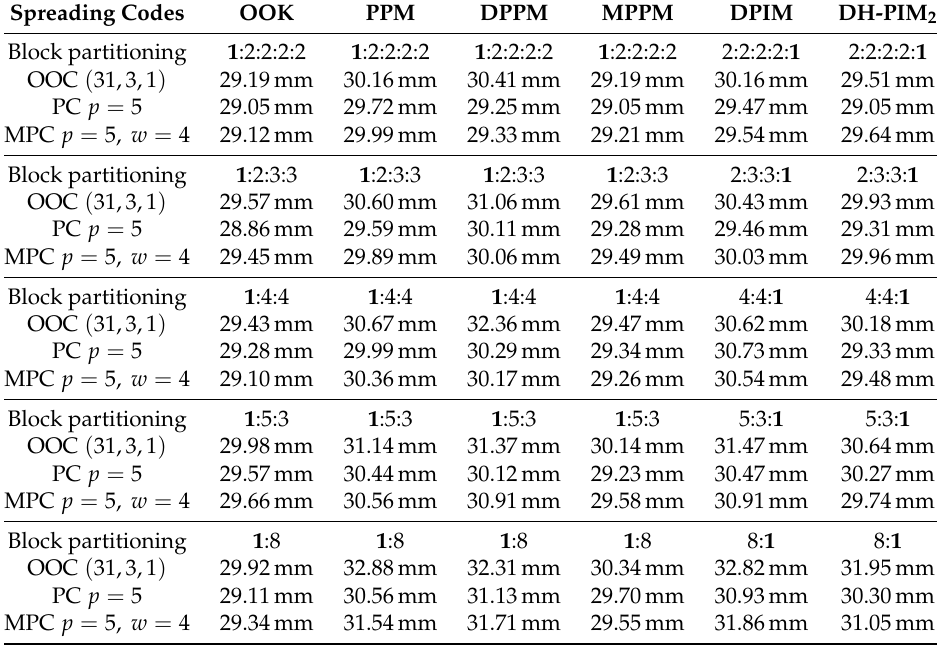
Table 15. Accuracy as a combination of modulation and spreading code.